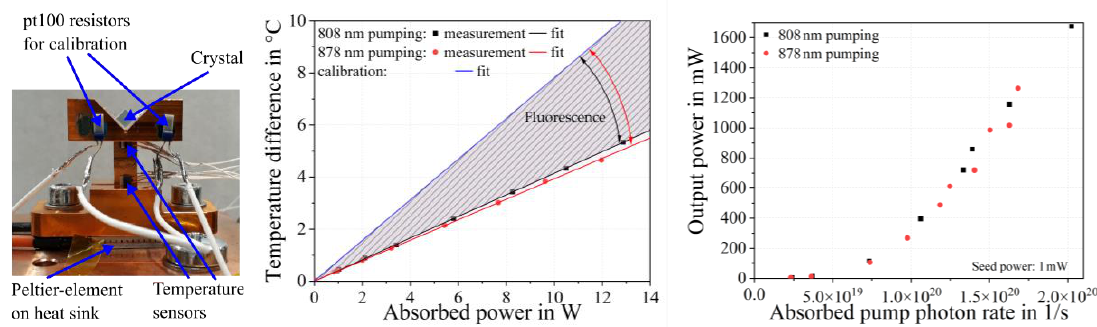
Fig. 1, left: crystal mount for thermal measurements, middle: temperature difference between temperature sensors over absorbed pump power, right: amplifier output power over absorbed pump photon